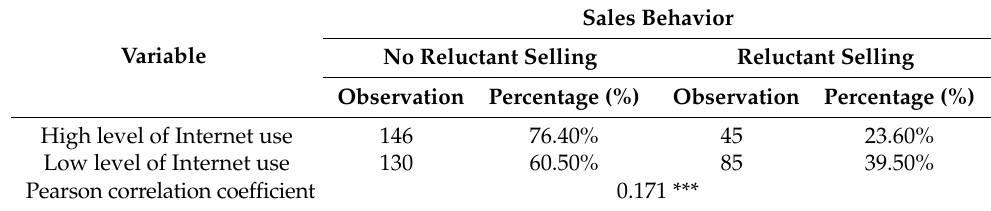
Table 4. Farmers’ sales behavior under the difference of Internet use